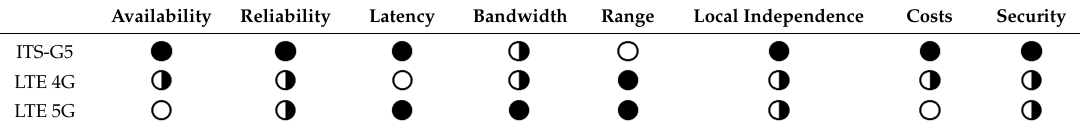
Table 2. Evaluation of the three planning levels for cooperation (circle: full = positive, empty = negative). CP: centralized planning; DP: decentralized planning with coordination; DPWC: decentralized planning without coordination.